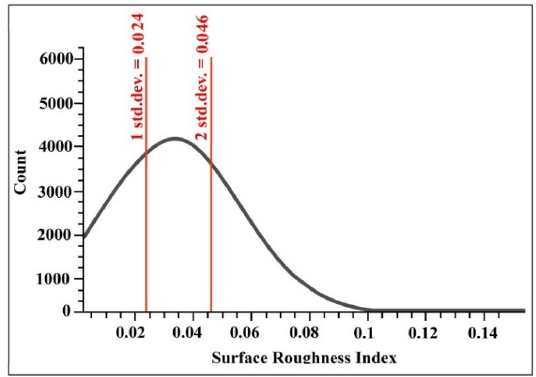
Figure 23. Statistics of the topographic surface roughness index distribution.